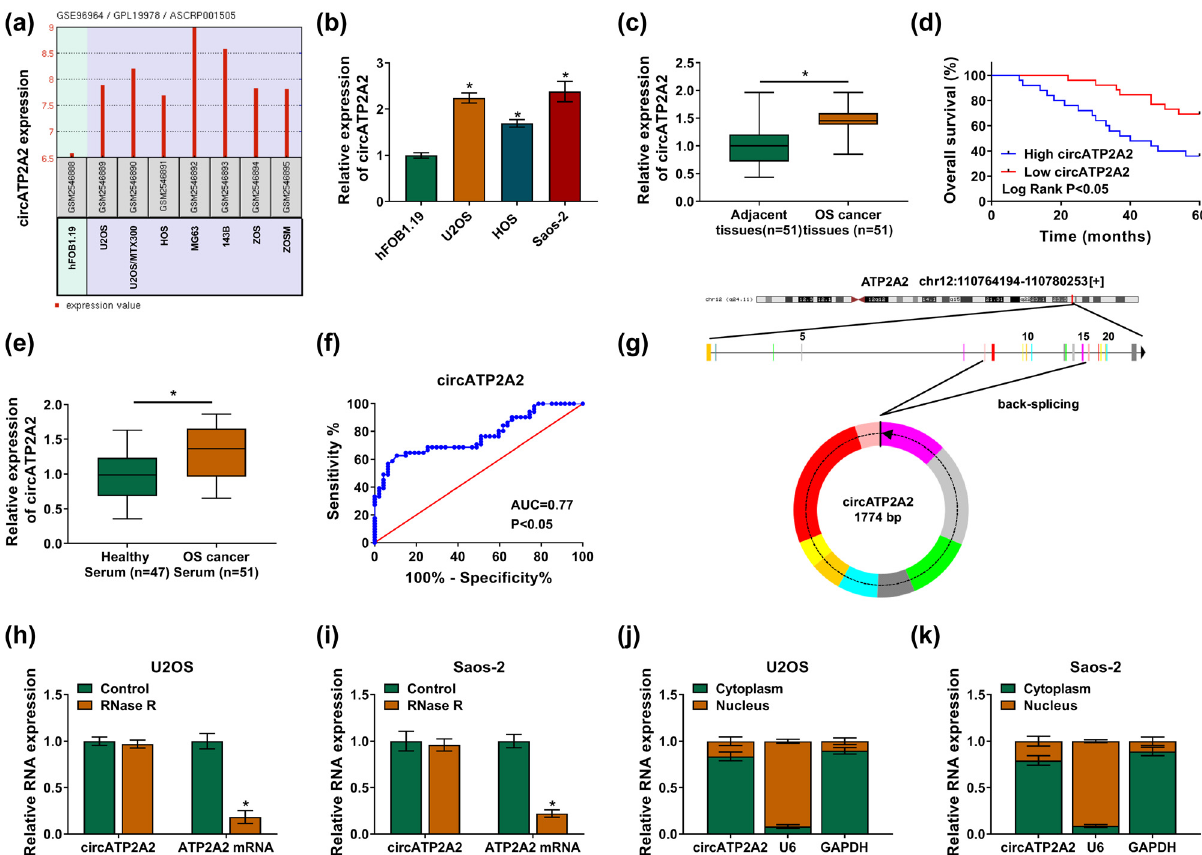
Figure 1: circATP2A2 might be a diagnostic and prognostic biomarker for OS patients. ( a ) The expression pattern of circATP2A2 in the GSE96964 dataset. ( b and c ) The expression of circATP2A2 in OS cells and tissues was detected by RT - qPCR. ( d ) Kaplan – Meier analysis revealed the overall survival rate of OS patients with high or low circATP2A2 expression. The median value of circATP2A2 ( the median value was 1.452 ) in OS tissues based on RT - qPCR was used as the cuto ff to de fi ne “ low ” or “ high ” circATP2A2 expression. ( e ) The expression of circATP2A2 in the serum of healthy people ( 47 ) and OS patients was assessed by RT - qPCR ( 51 ) . ( f ) The diagnostic value of circATP2A2 in serum was analyzed by the ROC curve. ( g ) The schematic diagram shows the formation of circATP2A2. ( h and i ) After RNase R treatment, the level of circATP2A2 in OS cells was analyzed by RT - qPCR. ( j and k ) The abundance of circATP2A2 in the cytoplasm and nucleus of OS cells was assessed by RT - qPCR. * P <